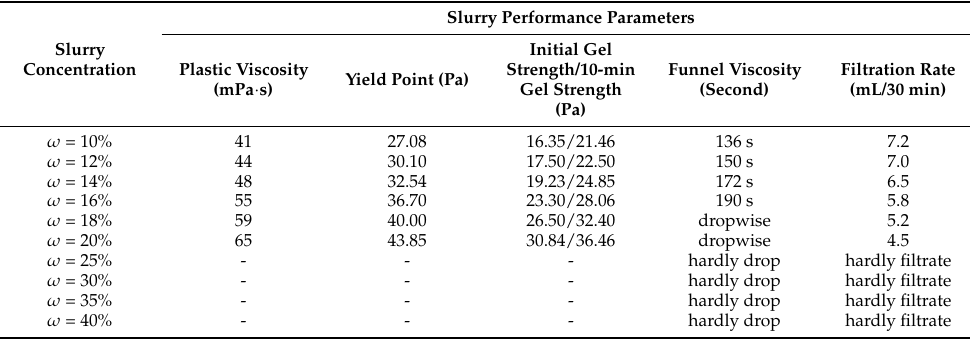
Table 1. Slurry performance parameters at different